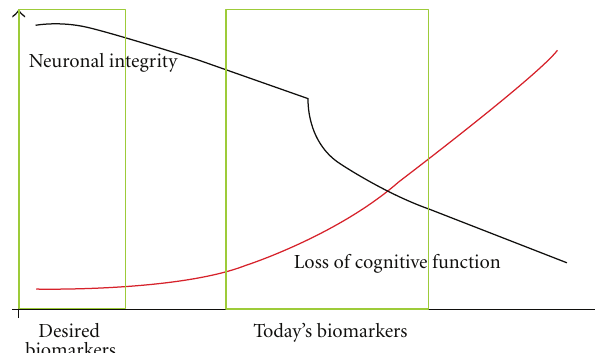
Figure 1: Schematic illustration of the alterations in neuronal integrity (black line) and subsequent loss of cognitive function (red line). The green boxes indicate at what level the presently available biomarkers have diagnostic/prognostic value, that is, once cognitive decline has begun, and at which level it is desired to be able to provide a prognosis/diagnosis, that is, biomarkers monitoring very early changes in neuronal